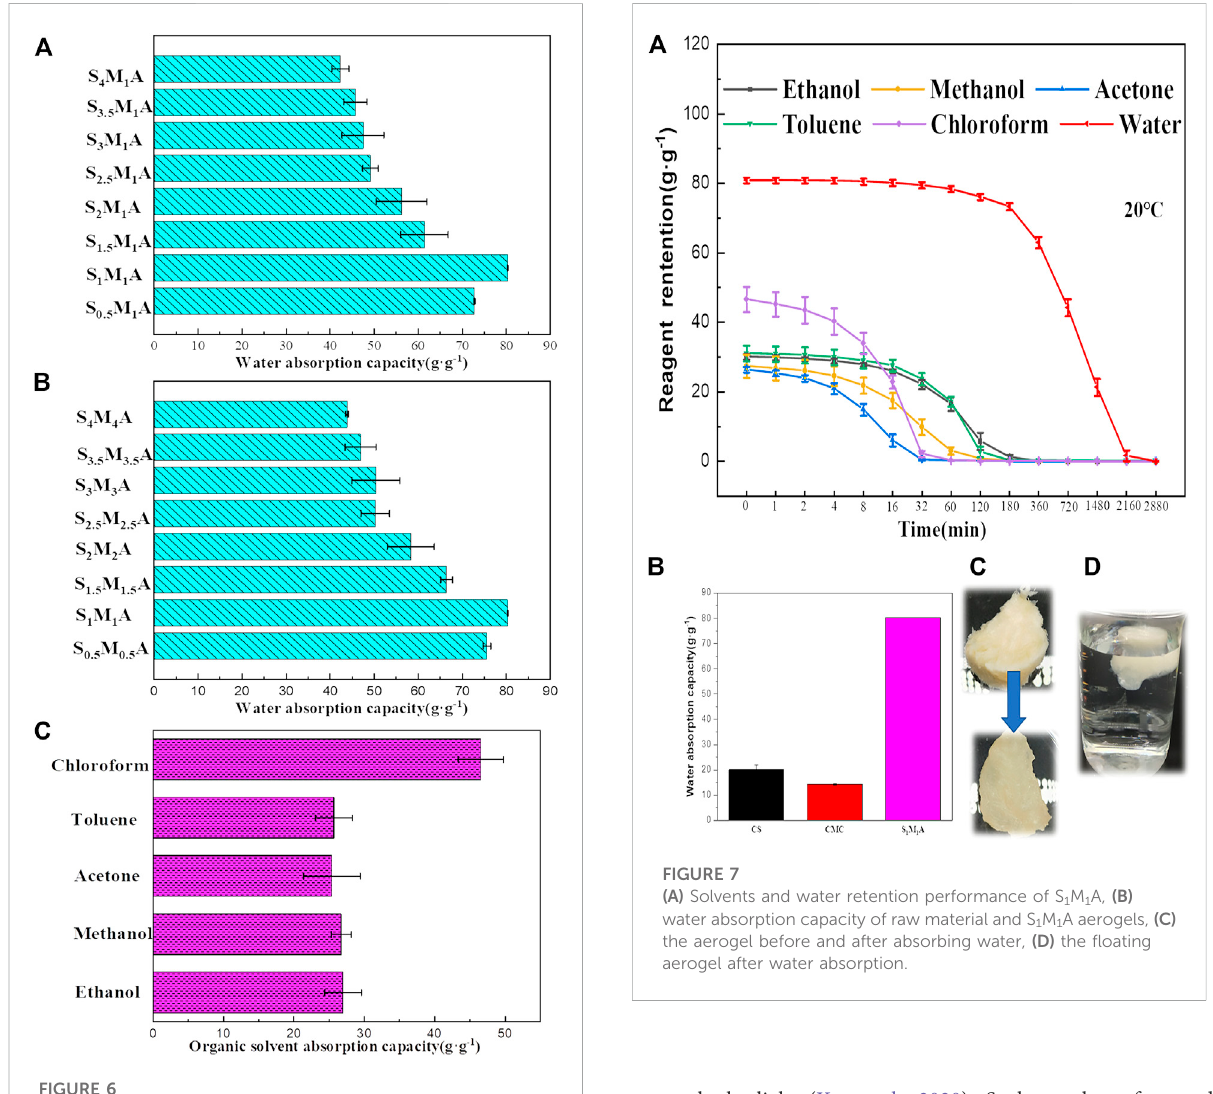
FIGURE 6 (A) Water absorption capacityofcompositeaerogels at1 wt% CMC solution and different CS solutions, (B) water absorption capacity of composite aerogels prepared at different mass concentration, (C) the sorption capacity of S 1 M 1 A for fi ve types of organic solvents.